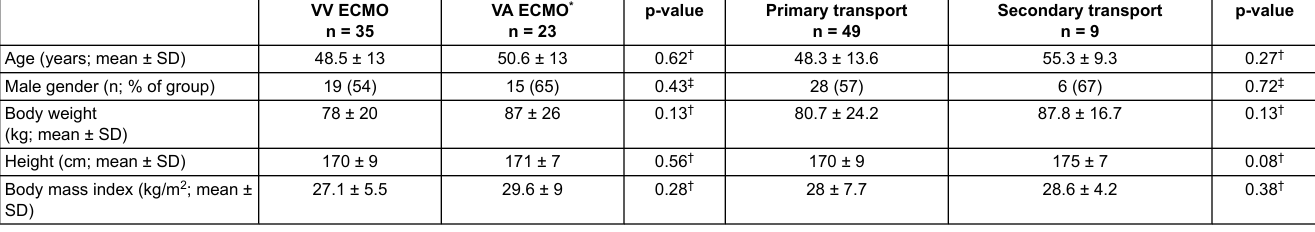
Table 3: Demographic data for study groups by type of extracorporeal membrane oxygenation (ECMO) and type of